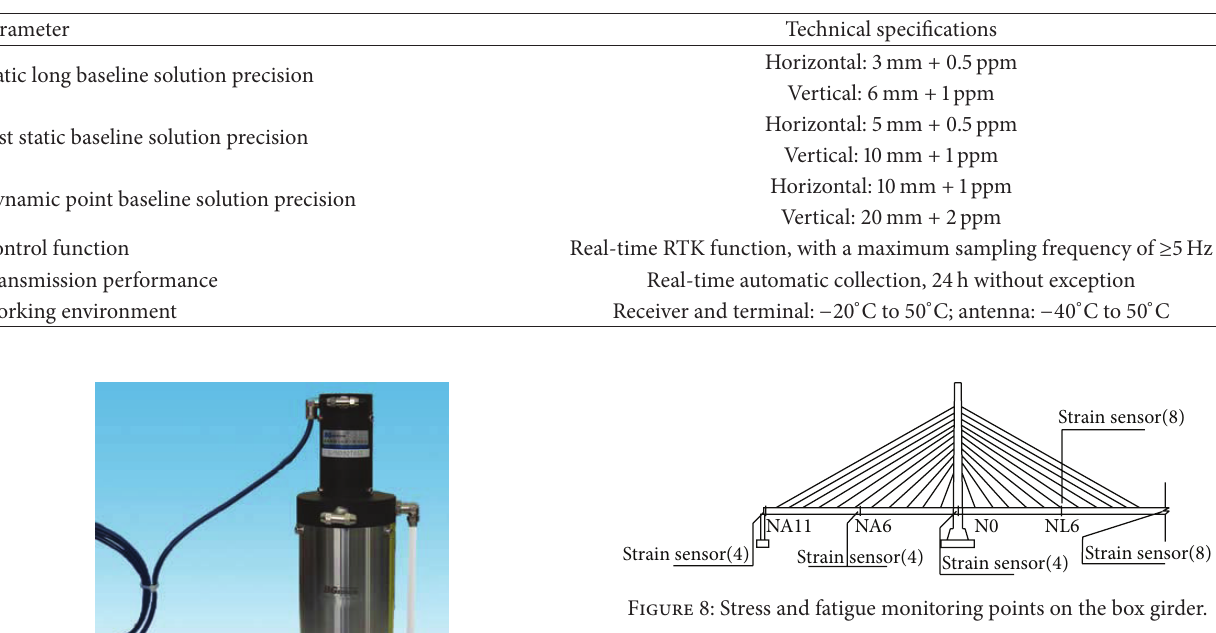
Table 4: Technical specifications of the GPS sensors.